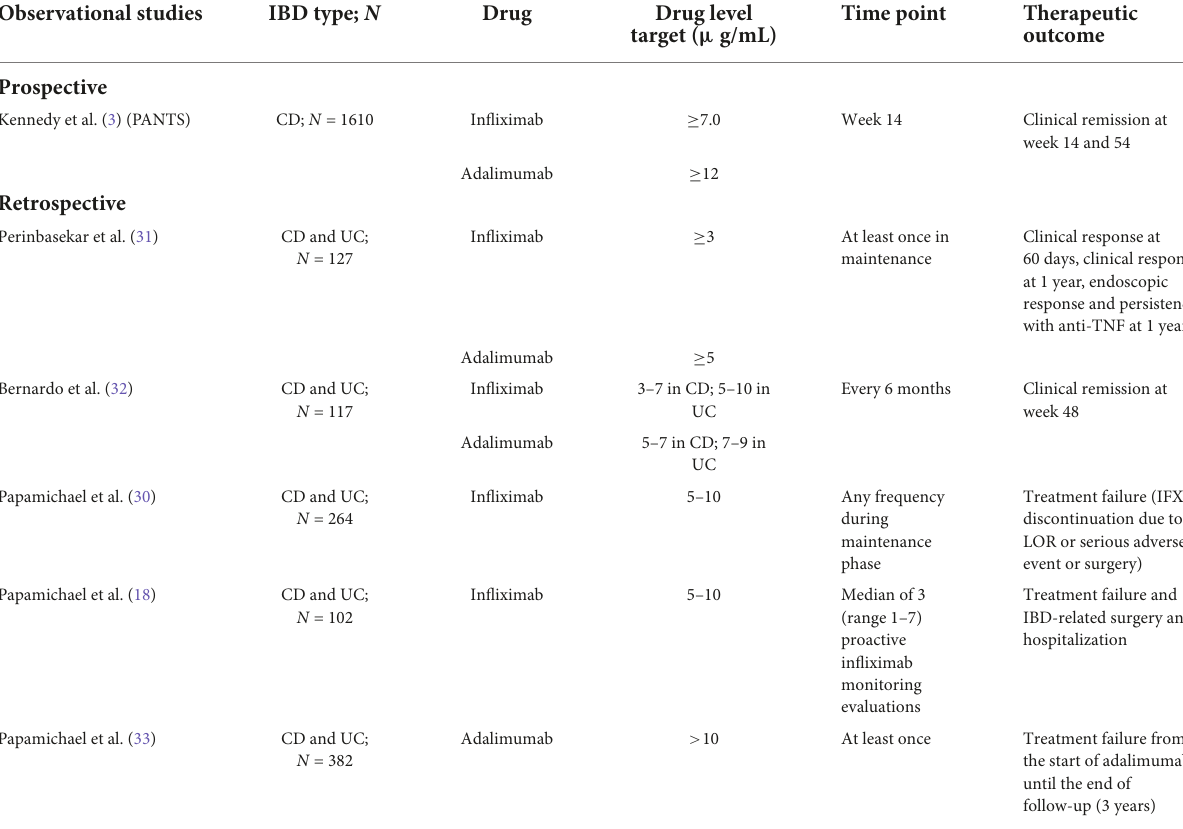
TABLE 4 Summary of most relevant observational proactive TDM studies in maintenance